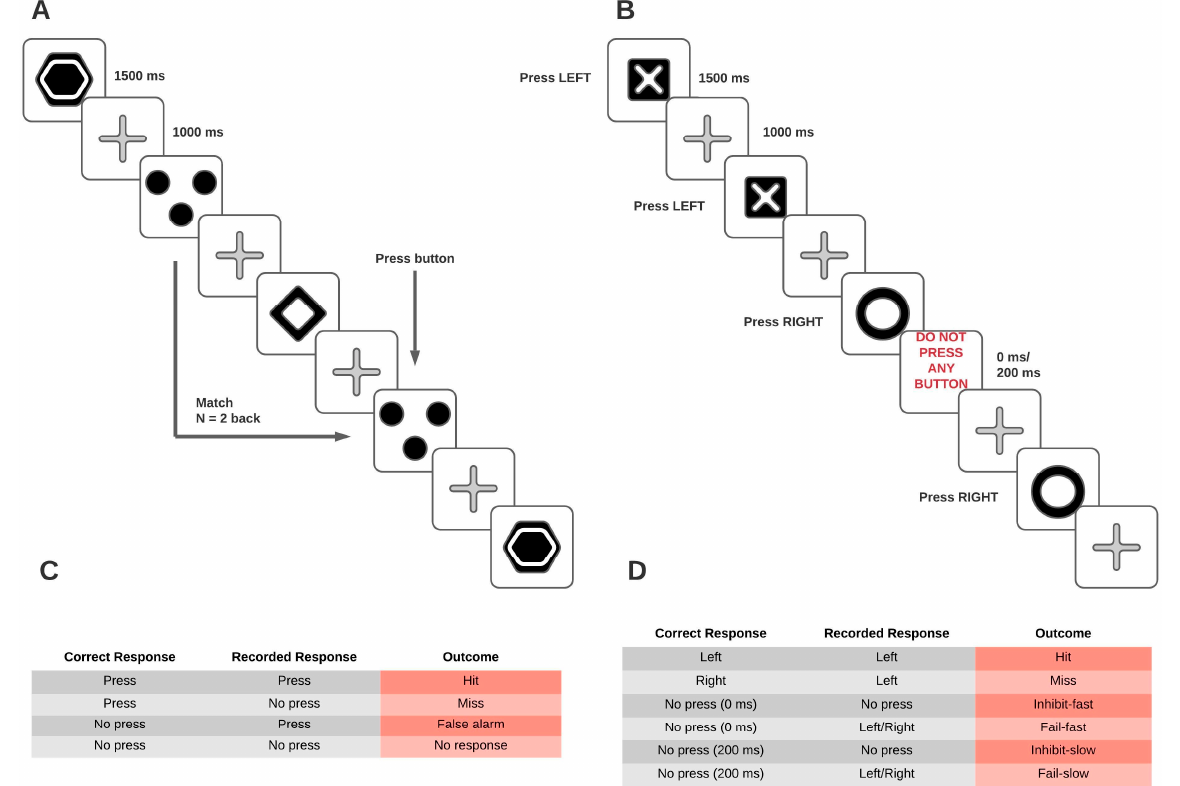
Figure 1. Schematic representation of the tasks used in the three scanning sessions. ( A ) shows an example of the stimuli the subject would see when performing the N-back task. ( B ) shows an example of the stimuli the subject would see when performing the Stop-Signal task. ( C,D ) respectively show the variables recorded for each run of the N-back and Stop-signal tasks (‘Outcome’ column), while also offering an explanation for when a response was considered correct.